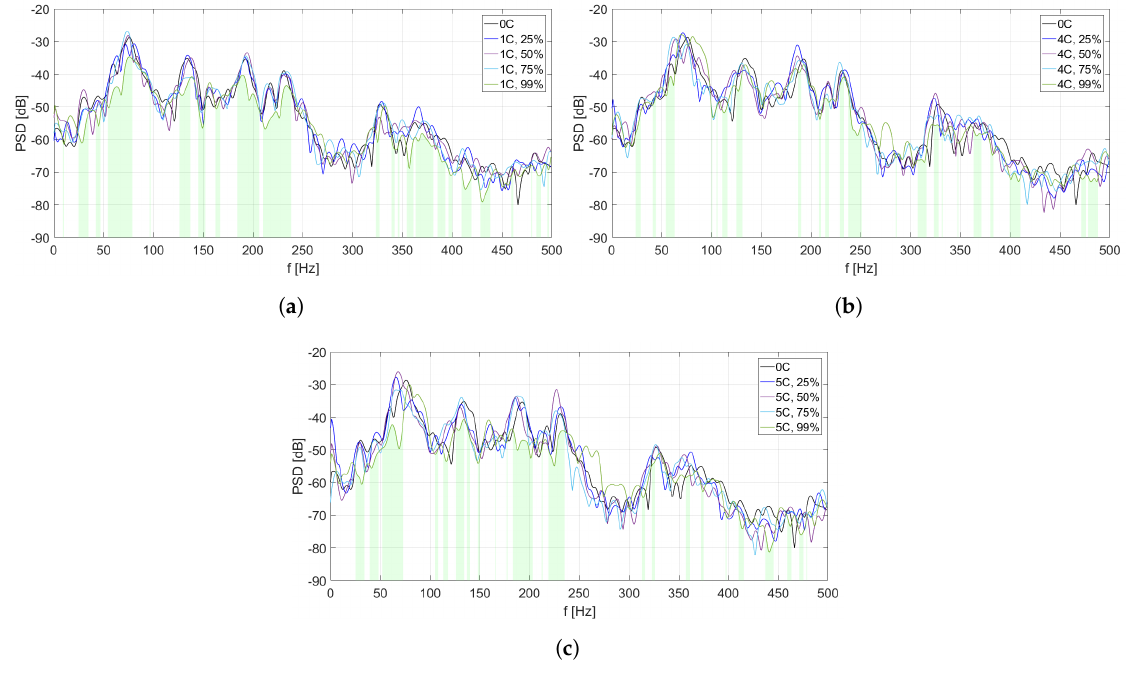
Figure 8. PSD estimates of MFC3 input signals: ( a ) scenario of one coupling activated, ( b ) scenario of four couplings activated, ( c ) scenario of five couplings activated.